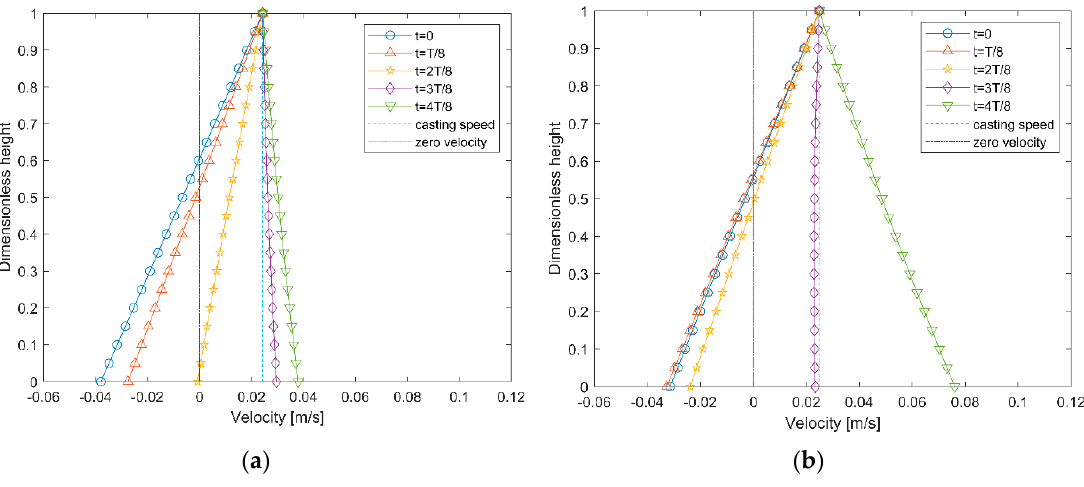
Figure 8. Transient velocity profiles at the center of slag film ( x = L /2) during the oscillation cycle: ( a ) A2 (sinusoidal oscillation), ( b ) A4 (non-sinusoidal oscillation with modification ratio α = 24%).